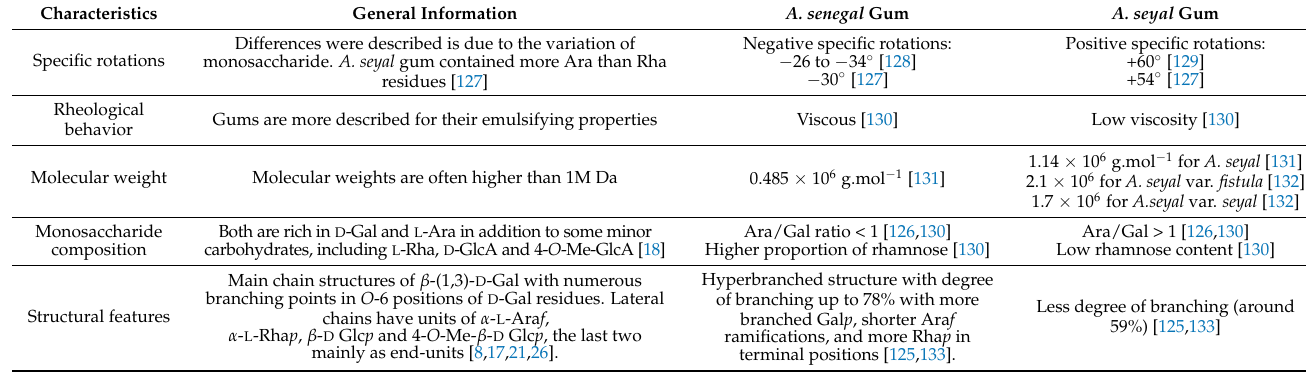
Table 4. Main characteristics of A. senegal and A. seyal